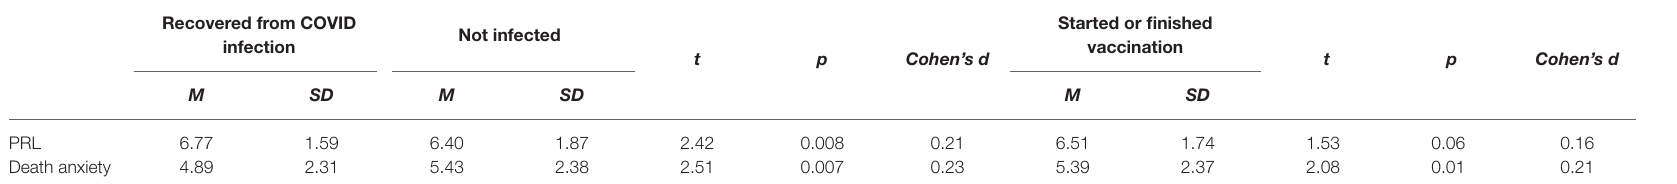
TABLE 5 | Differences in PRL and death anxiety (mean comparison t-tests, Study 2). Recovered from COVID Not infected infection